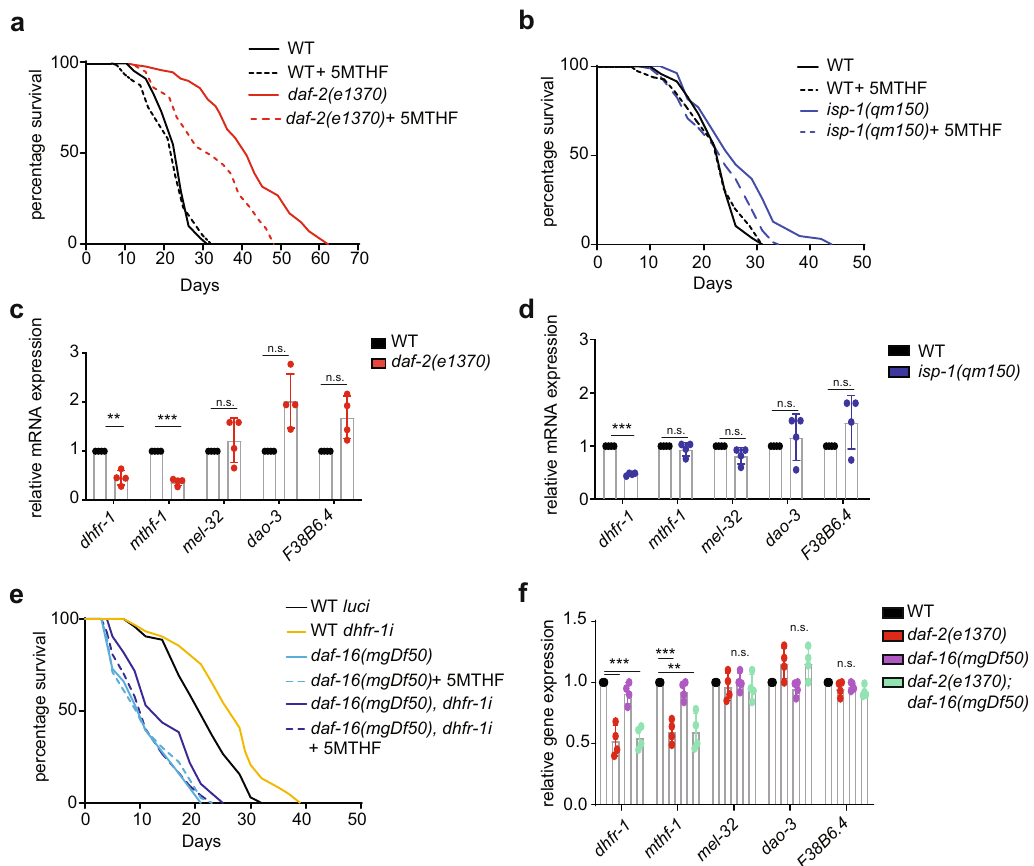
Fig. 4 dhfr-1 and 5MTHF act within insulin/IGF and mitochondrial signaling pathways. a Life span of daf-2(e1370) supplemented with 10 nM 5MTHF (from L4 stage). b Life span of isp-1(qm150) supplemented with 10 nM 5MTHF (from L4 stage). 5MTHF does not alter WT life span but reduces daf-2 and isp-1 longevity. c , d Relative mRNA expression of folate cycle genes in daf-2(e1370) and isp-1(qm150) (day 1 adult). dhfr-1 mRNA expression is lower in both genotypes. e Life span experiment of wild-type and daf-16(mgDf50) with luci and dhfr-1i in the presence or absence of 5MTHF (from L4 stage). dhfr-1i extends daf-16 mutant life span and supplementation with 5MTHF abolishes this extension. f Relative mRNA expression of folate cycle genes in daf-16 and daf-16,daf-2 backgrounds. daf-16 mutation has little or no effect on dhfr-1 or mthf-1 mRNA expression in the daf-2 background. a , b , e n = 150 per repeat per condition, N = 3 independent biological replicates. c , d , f N = 3 biological replicates. a , b , e Statistics were analyzed by the two-sided Mantel – Cox log-rank test (Supplementary Table 7 for statistics). c , d , f Signi fi cance was assessed using one-way ANOVA and Dunnett ’ s multiple comparisons test. * p <